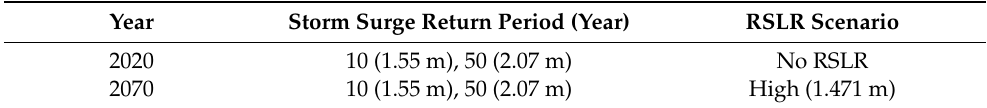
Table 1. Relative sea level rise and storm surge scenarios (NAVD88) prepared for the storm surge model from [20]. Water levels are at the Sewells Point tide gauge in Norfolk,